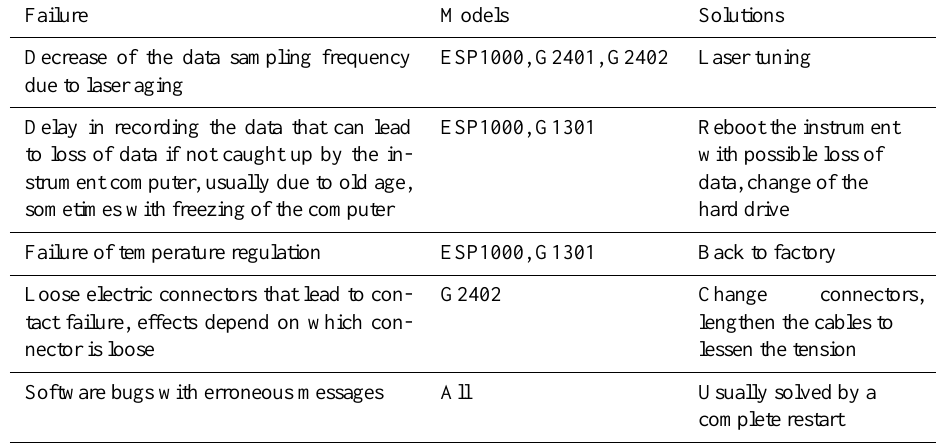
ESP1000, G2401, G2402 Laser tuning ESP1000, G1301 Reboot the instrument with possible loss of data, change of the hard drive